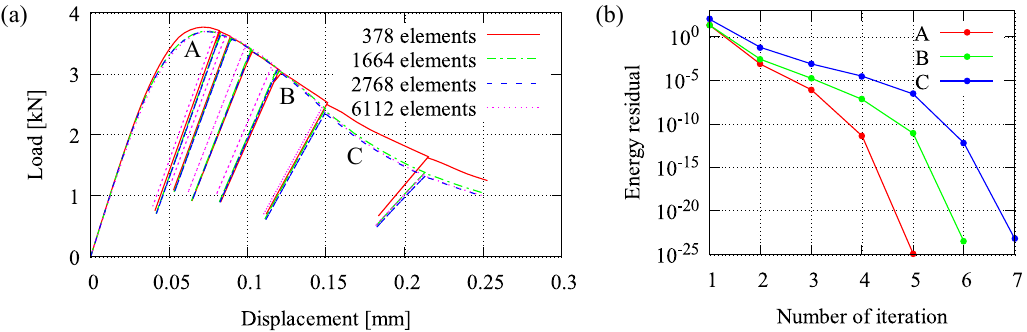
Figure 10. Four-point bending simulation: ( a ) comparison of different mesh densities and ( b ) accompanying convergence rates for mesh with 2768 elements.